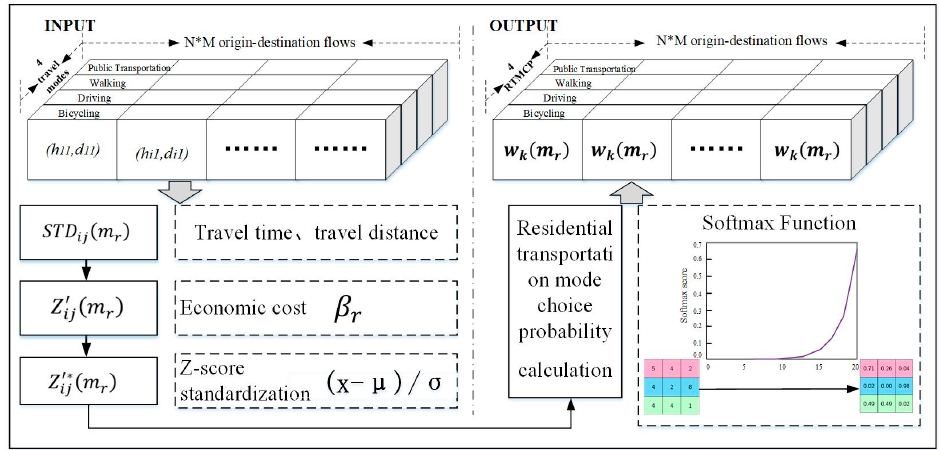
Figure 3. The RTMC theoretical model diagram.